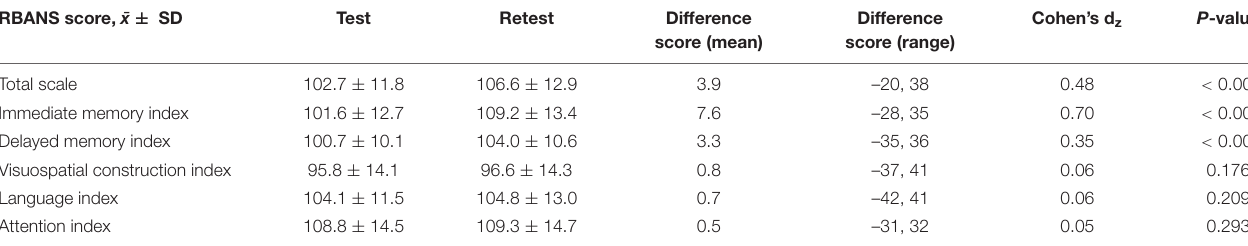
TABLE 2 | Differences between test and retest performance in repeatable battery for the assessment of neuropsychological status (RBANS) ( N = 502).